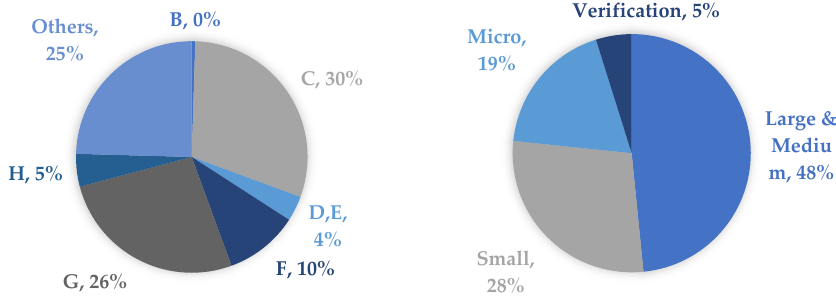
Figure 1. Structure by size and section within the analyzed sample relating to non-financial operations conducted in 2020.